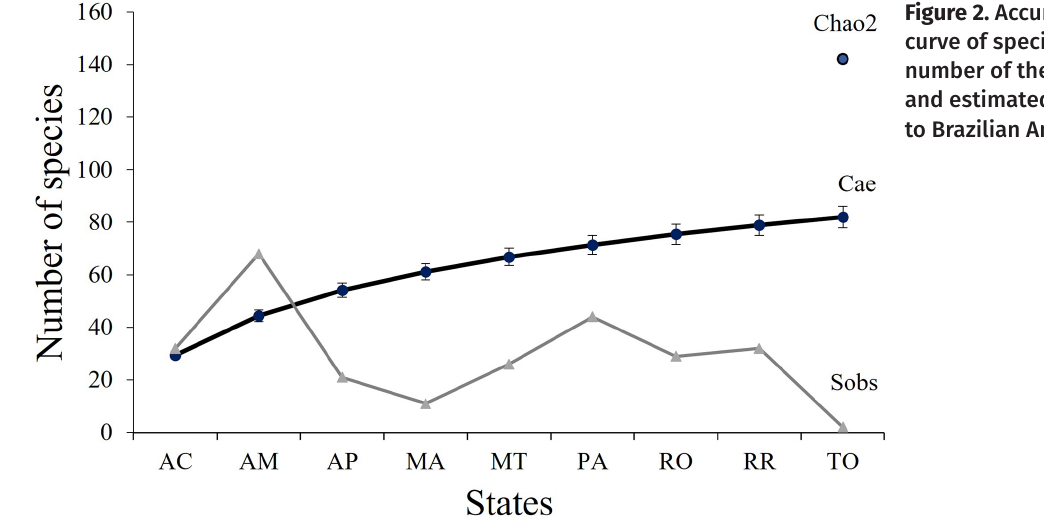
Figure 2. Accumulation curve of species and number of the observed and estimated richness to Brazilian